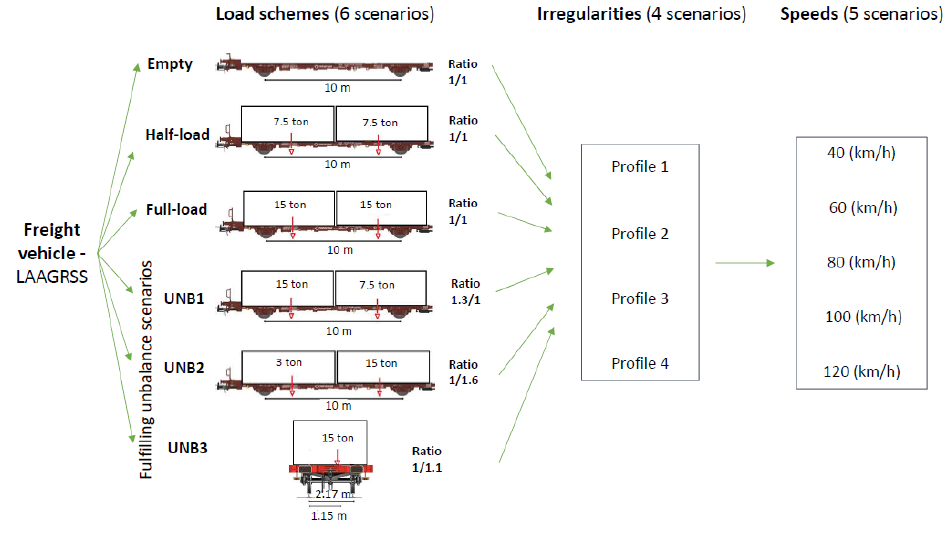
Figure 6. Baseline scenarios.